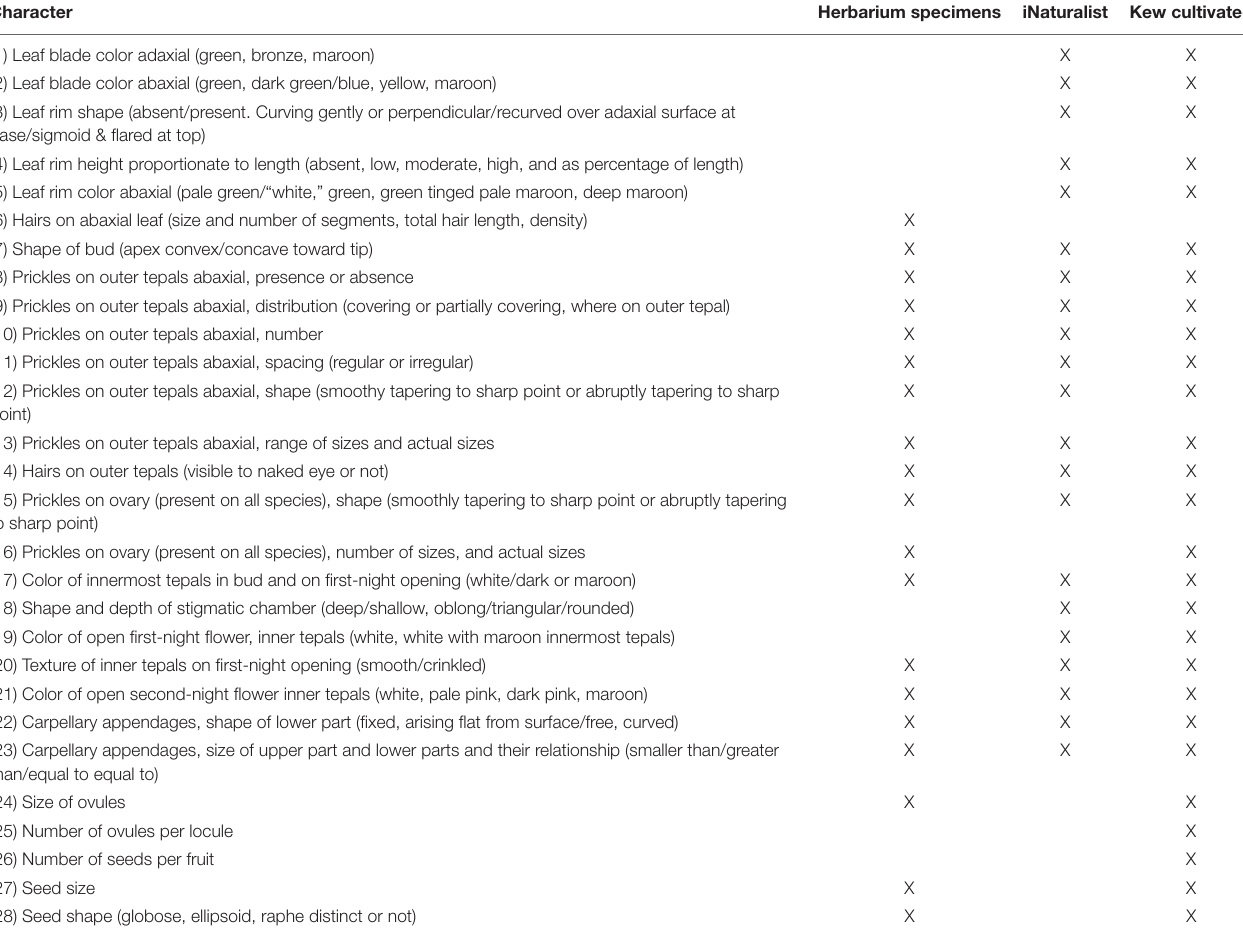
TABLE 1 | Source of contrasting morphological characters and their states from herbarium, horticultural, or field image data.